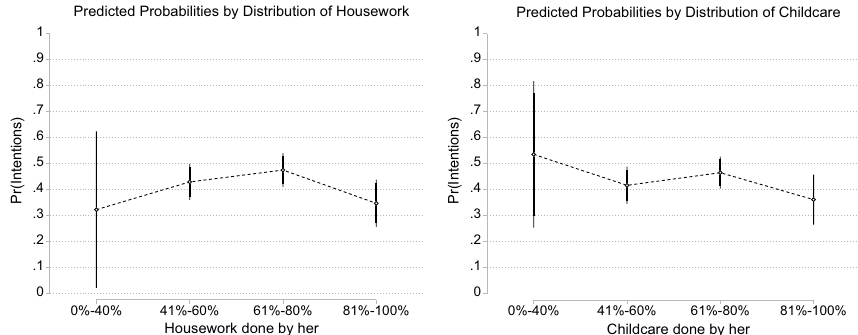
Fig. 7 Predicted probabilities of one-child mothers’ fertility intentions by housework/ childcare distribution where both partners work full-time. Error bars at 90% (thin) and 95% (thick). Models control for housework/ childcare duties done by other individuals, woman’s age, child’s age, migrant background, women’s attachment to the labour force, men’s labour force status, partners’ educational attainment, differences in educational attainment, partner’s children and partnership satisfaction